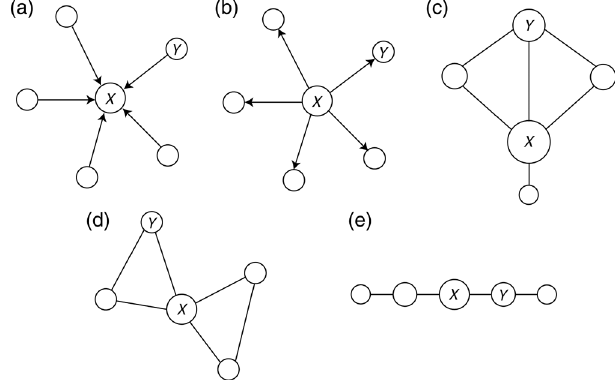
FIG. 3. An excerpt from the SNA survey that was given starting in the Spring 2015 semester.